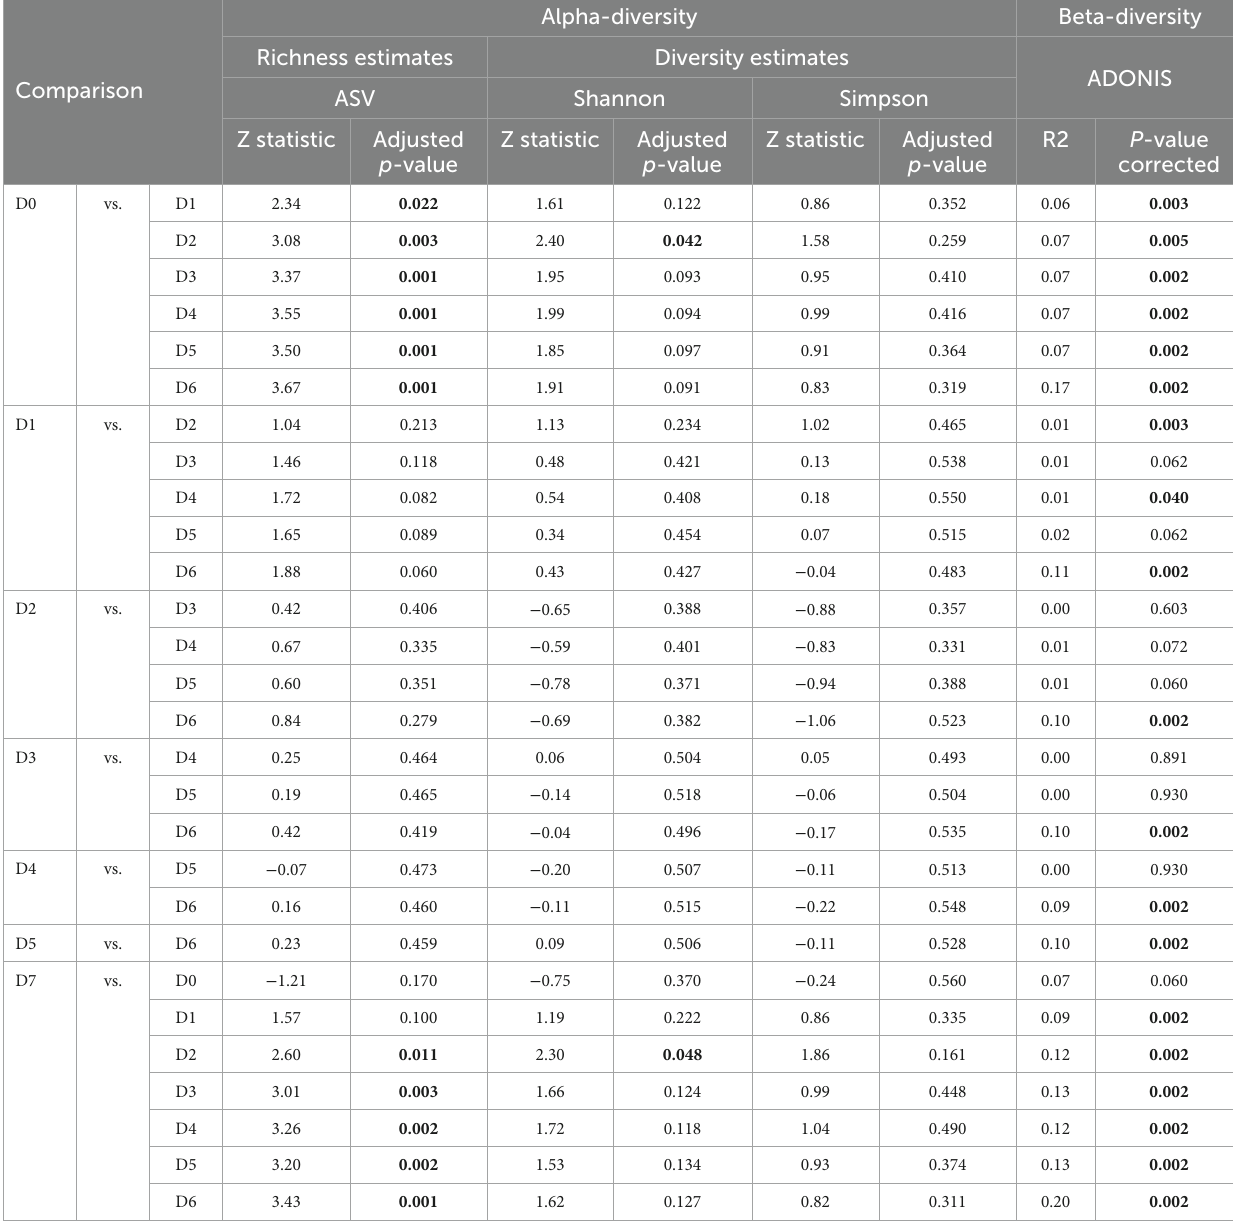
TABLE 2 Alpha- and beta-diversity of microbial community of different washout fractions of cestodes obtained before and after